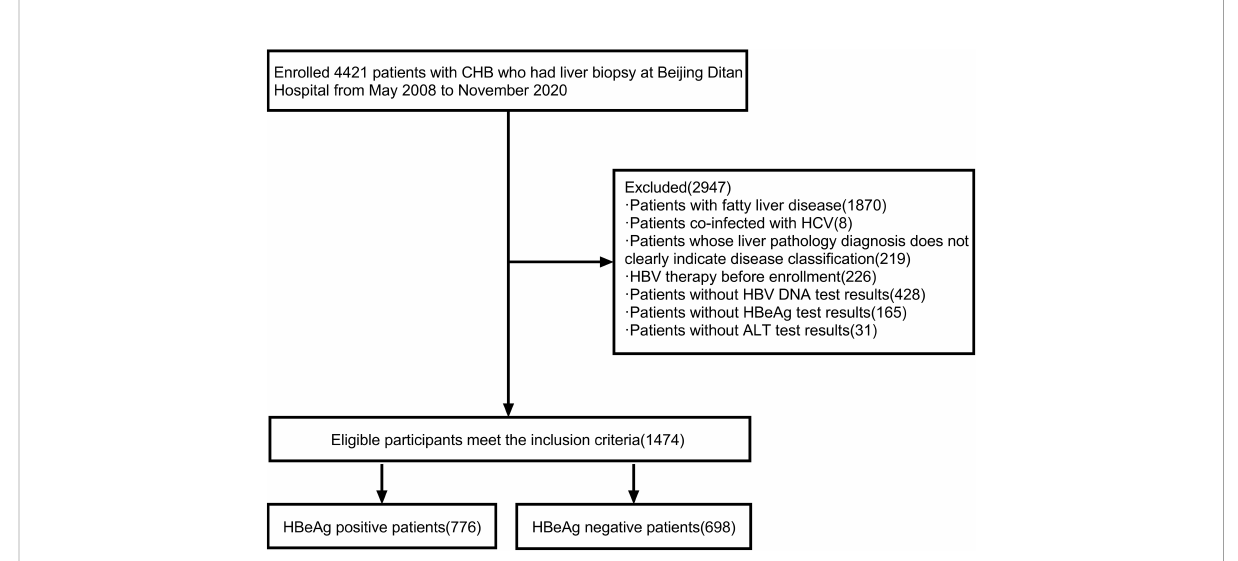
FIGURE 1 Flow chart of the screening process of the research patients. CHB, chronic hepatitis B; HCV, hepatitis C virus; HBV DNA, hepatitis B virus deoxyribonucleic acid; HBV, hepatitis B virus; ALT, alanine aminotransferase; HBeAg, hepatitis B e